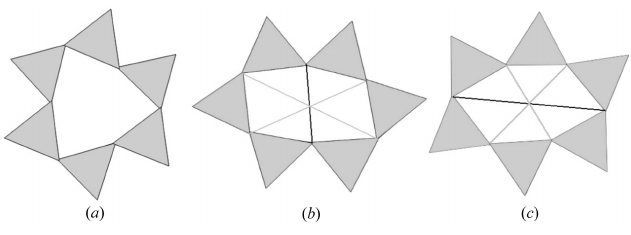
Figure 9 Different D6R conformations observed in kaliophilite. ( a ) Eclipsed trigonal ( et ), ( b ) eclipsed oval oblate ( eo ) and ( c ) eclipsed oval prolate ( ep